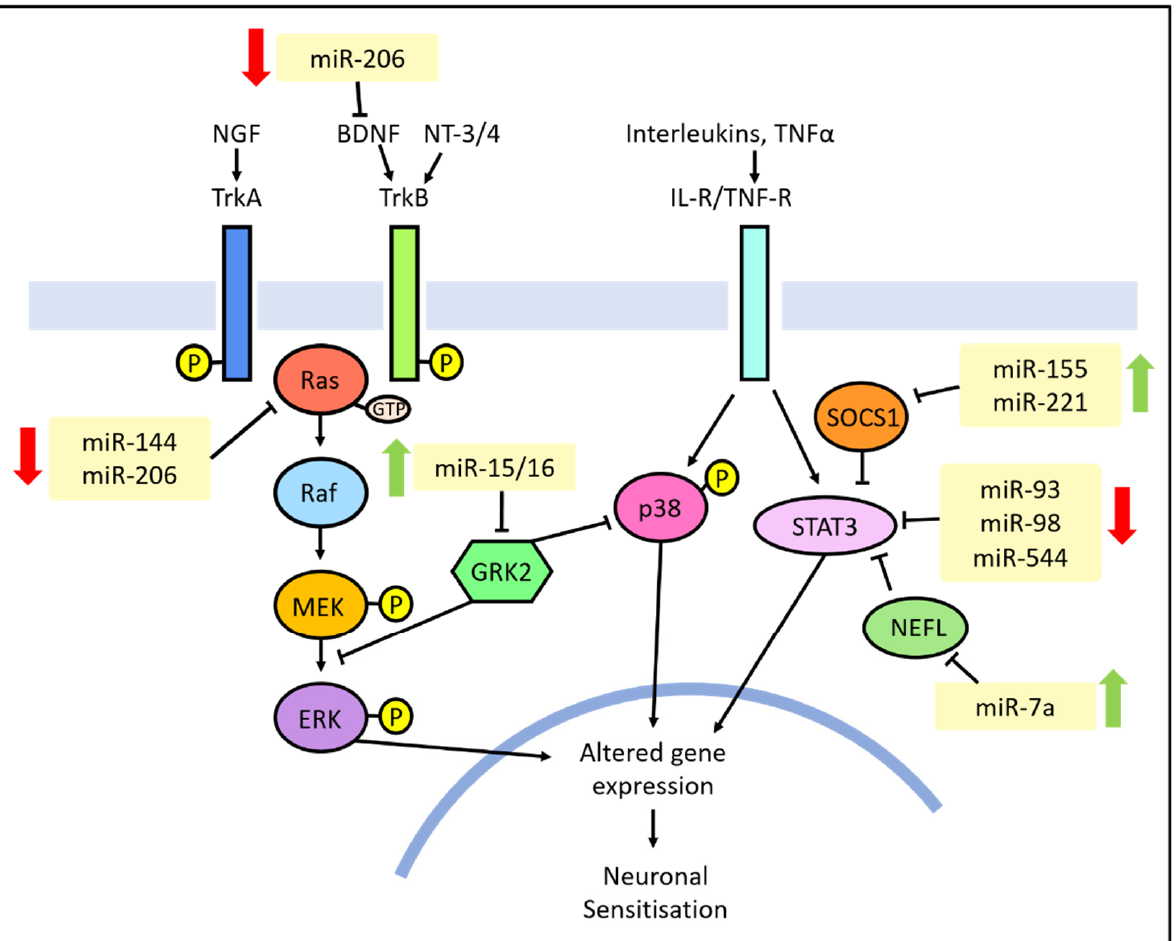
Figure 3. Diagram displaying miRNA dysregulated in neuropathic pain and their targets involved in intracellular signalling. Red downward arrows indicate that the miRNA is downregulated during neuropathic pain, whilst upward green arrows indicate miRNA upregulation in neuropathic pain.